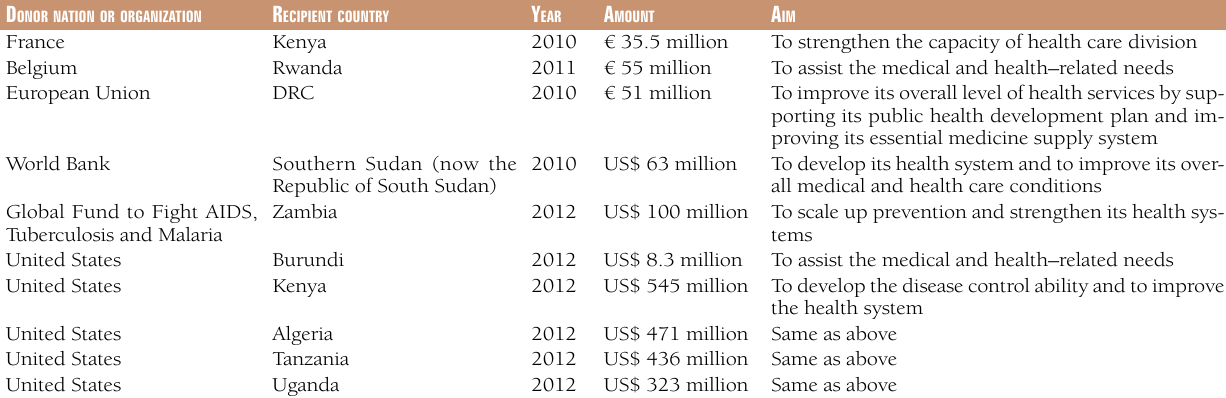
Table 2. The amount of financial support that some donor nations and international organizations provided to selected recipient countries